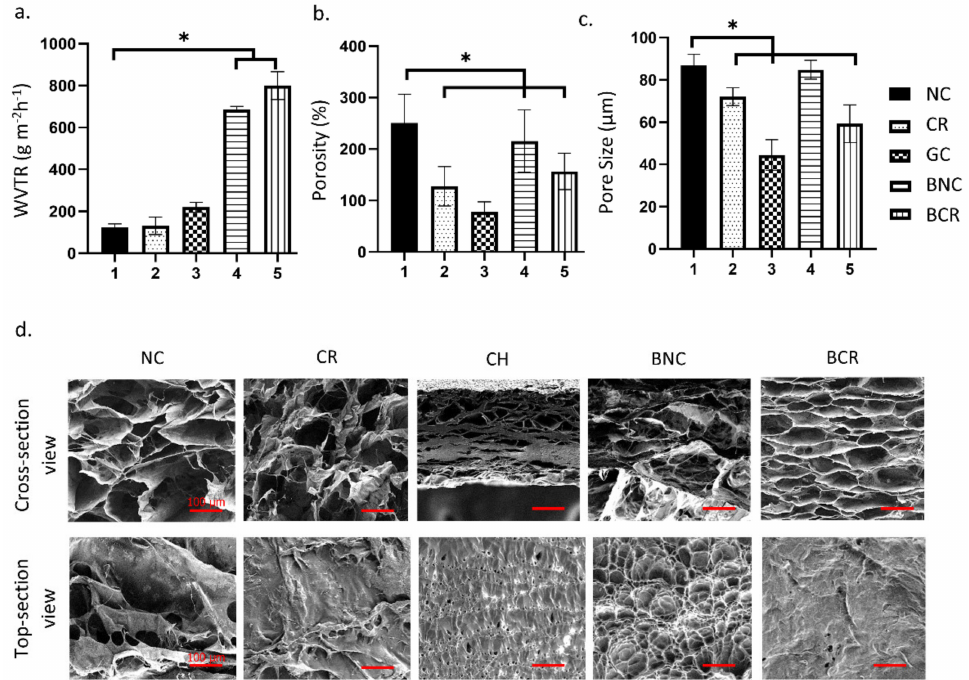
Figure 4. The porosity study of the scaffolds at room temperature. ( a ) The water vapor transmission rate, ( b ) the porosity of the scaffolds, ( c ) the pore size of the scaffolds, and SEM morphology of the scaffolds ( d ) cross-section view of scaffolds and top section view of scaffolds. * p < 0.05 indicates the siginificant differences of the fabricated